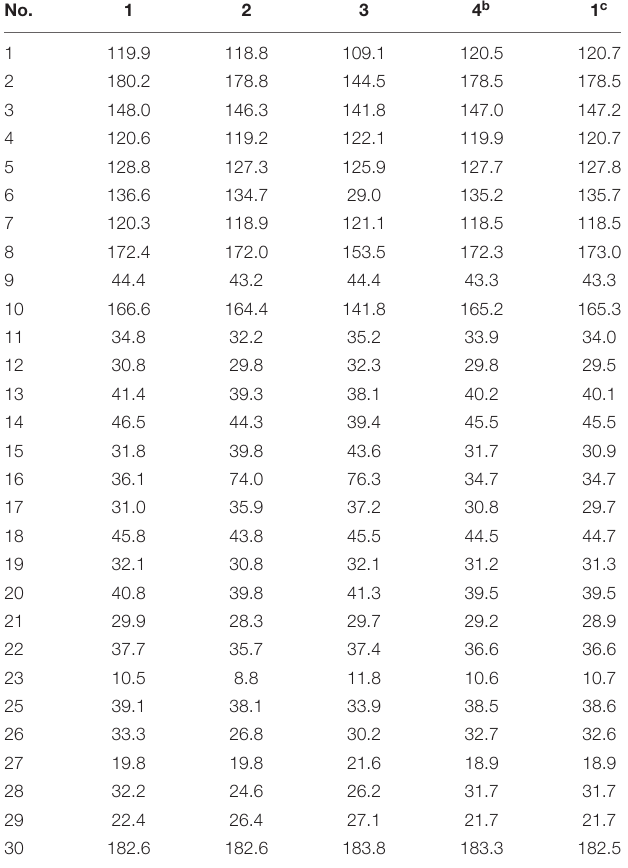
TABLE 2 | 13 C NMR spectroscopic data for compounds 1–3 in CD 3 OD and 4 in CDCl 3a . No.